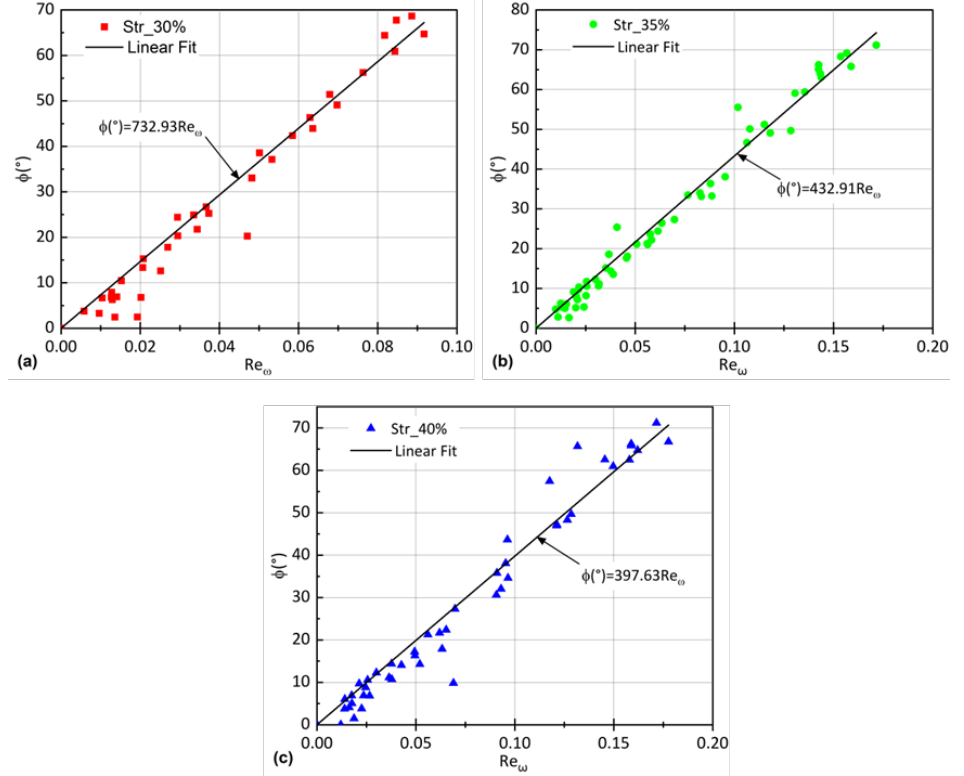
Figure 16. Evolution of the phase shift 𝜙 for each regenerator (( a ): Str_30%, ( b ): Str_35%, ( c ): Str_40%) as a function of the kinetic Reynolds number Re ω for different strokes ( C 1 = 64.4 mm and C 2 = 128.4 mm), lengths ( L 1 = 60 mm and L 2 = 70 mm) and temperature gradients ( Δ T 1 = 70 °C/10 °C and ∆ T 2 = 40 °C/10 °C).